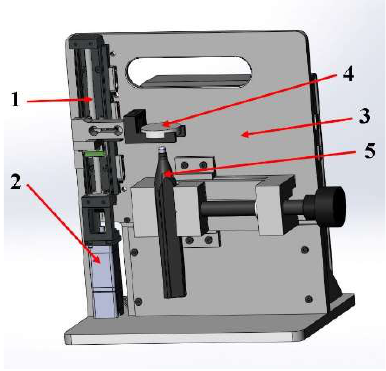
Figure 7. Non-conductive coating thickness simulating system. 1—precision linear actuator, 2—servo drive, 3—basic supporting structure, 4—reference base metal, 5—ECP.